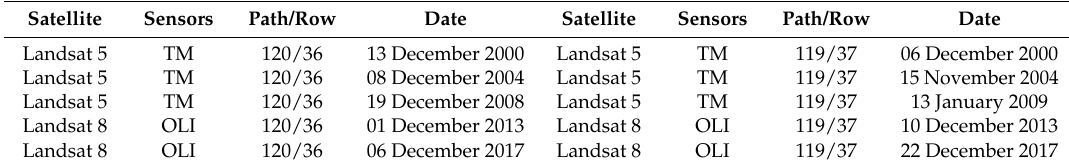
Table 1. Details of the landsat remote sensing data used in this study (spatial resolution: 30 m).